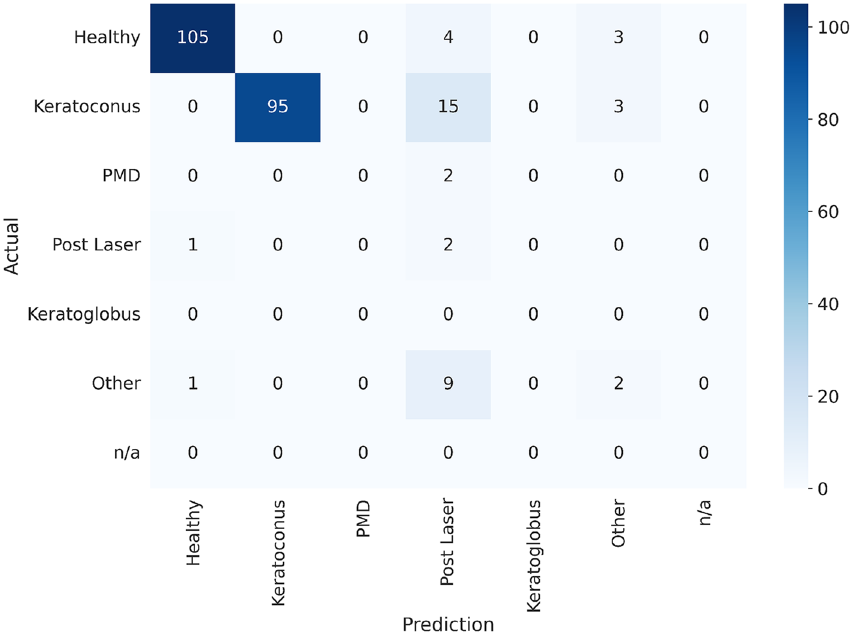
Figure 3. Confusion matrix 20,29 of the test cornea scans dataset. The Prediction axis shows the actual prediction from the CorNeXt model and the Actual axis shows the ground truth labels.